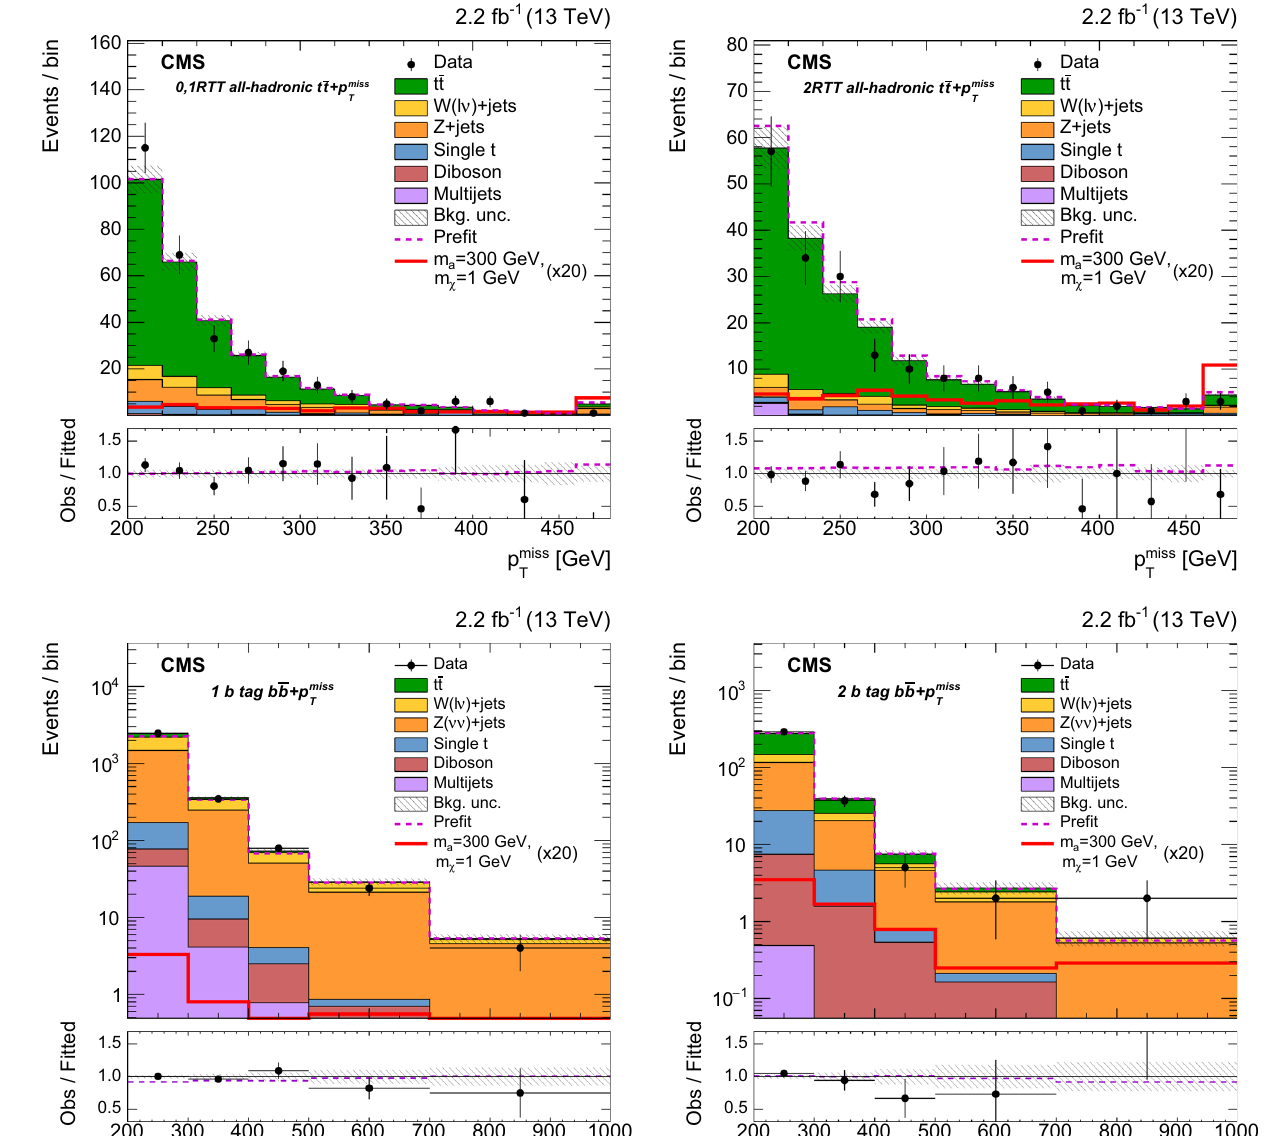
The following sources of uncertainty correspond to con- shape nuisance parameters in the fit: strained p miss T – PDF uncertainties Uncertainties due to the choice of PDFs are estimated by reweighting the samples with the ensemble of PDF replicas provided by NNPDF3.0